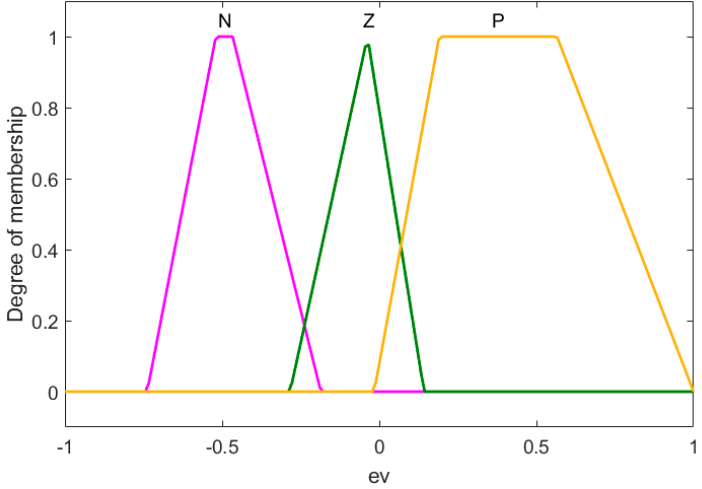
Figure 13. Membership functions for Input 1.